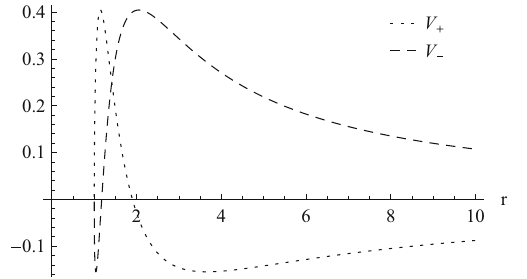
Fig. 1 The behavior of the effective potentials V + ( dotted line ) and V − ( dashed line ) for r + = 1 and κ =